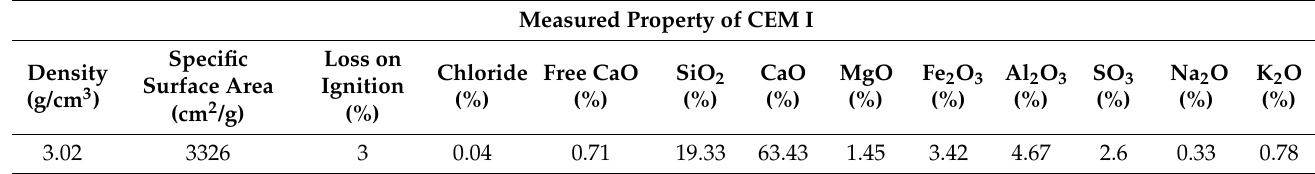
Table 1. Chemical compositions and physical properties of cement.